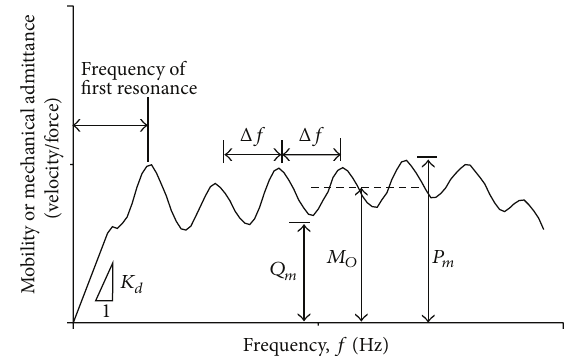
Figure 1: Idealised results of a vibration test by the TRM